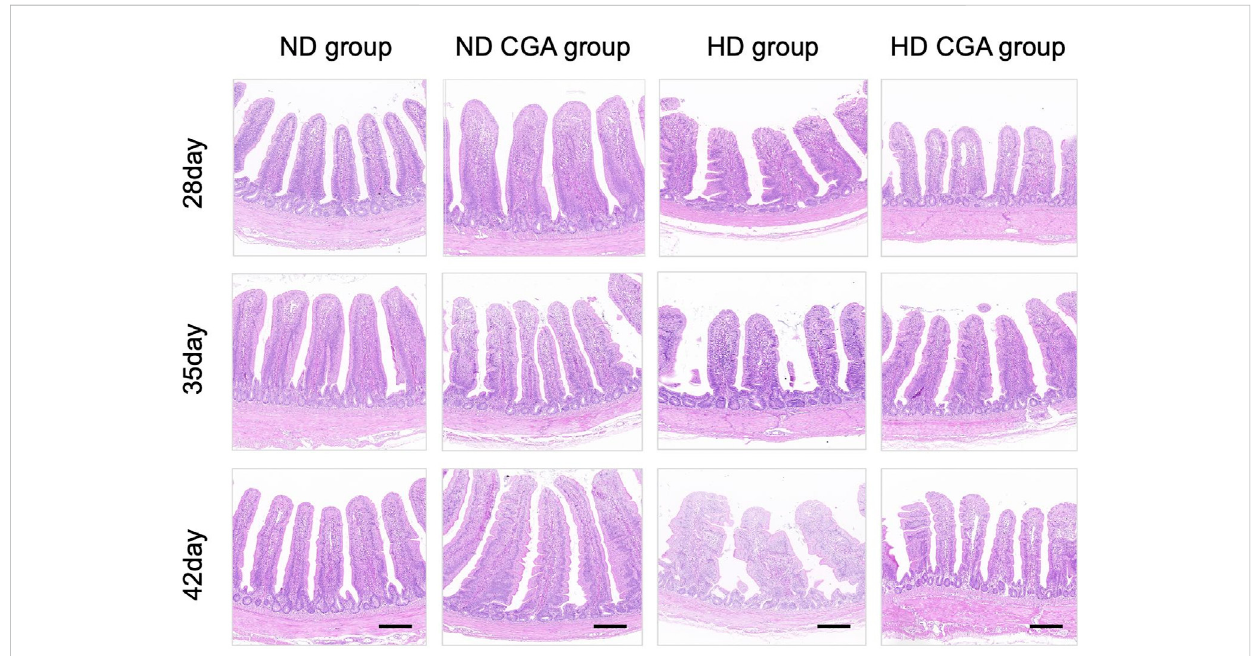
FIGURE 1 EffectsofCGAonileummorphologyofbroilersunderHDstress.NDgroup, normalstockingdensity+basaldiet;ND+CGAgroup,normalstocking density + basal diet +0.15% CGA; HD group, high stocking density + basal diet; HD + CGA group, high stocking density + basal diet +0.15% CGA. Scale bar = 100